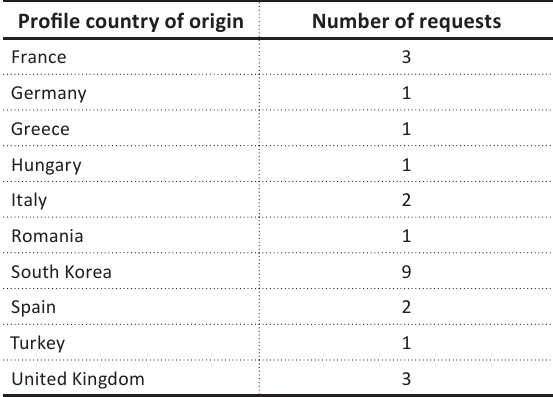
Table 5. Geography of profile of country of origin for entrepreneurs having the profile type “R&D request” and are interested in cooperation with Ukraine for the first half of 2019